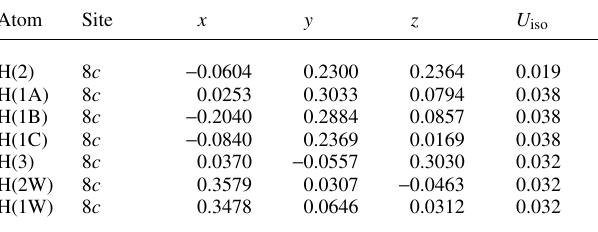
Table 3. Atomic coordinates and displacement parameters (in Å 2 )